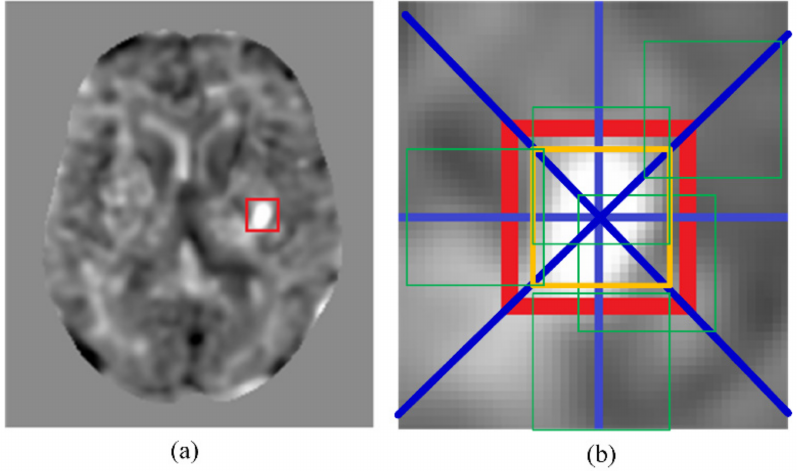
Figure 2. An example of data augmentation. ( a ) A t-score map with an infarcted region in the red box. ( b ) The golden box represents the initial patch location. The green boxes are examples of additional patches due to the data augmentation. The blue lines show the eight shifting directions to create the additional